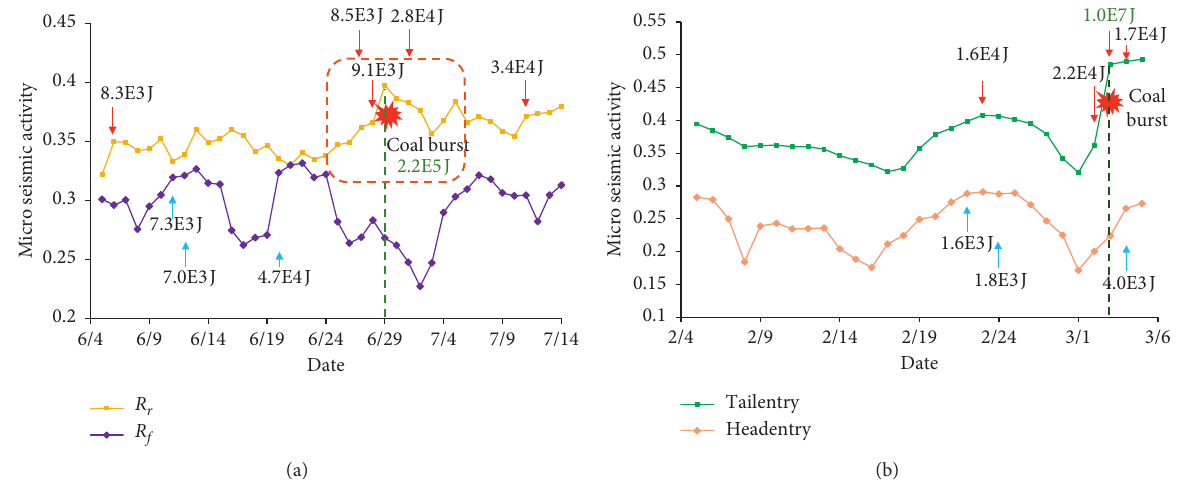
Figure 8: Variation curve of microseismic activity value. (a) LW5521-20. (b) LW11-3102.